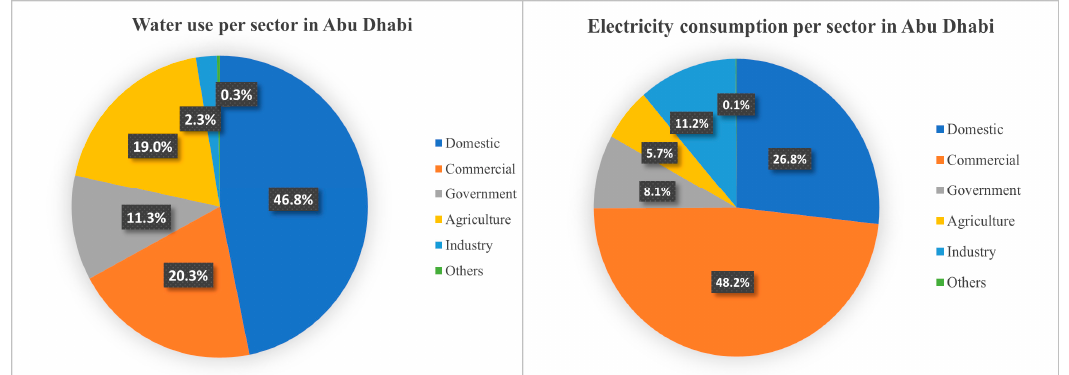
Figure 1. Water and electricity use per sector in the United Arab Emirates (UAE) (adapted from [38]).